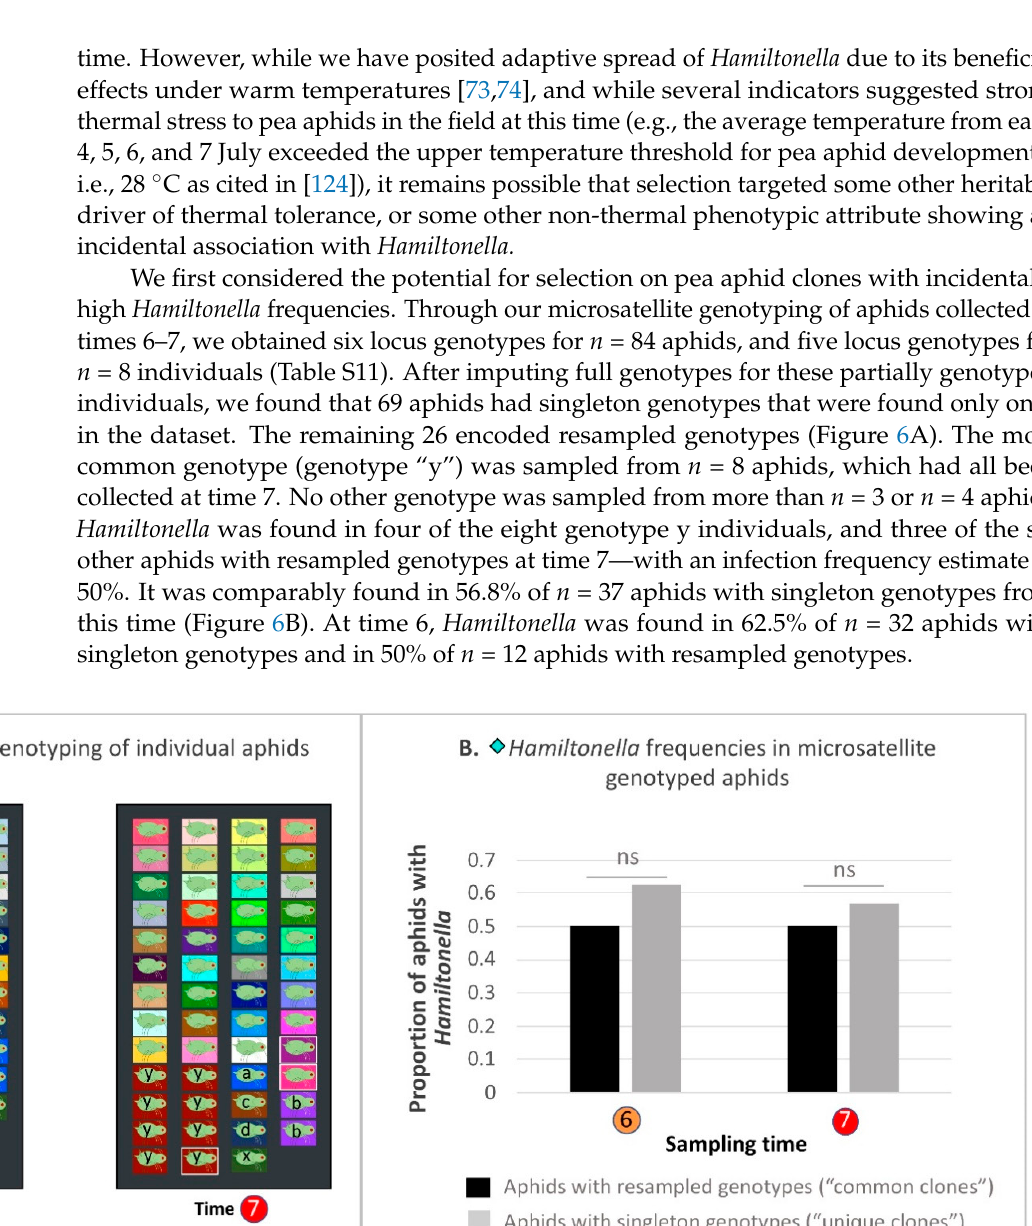
26 of 38 Figure 5. Direct selection vs. hitchhiking effects for facultative symbionts of pea aphids across overwintering periods. As shown in Smith et al. 2021, Hamiltonella frequencies declined across two overwintering periods. Illustrated here, in addi- tion to Hamiltonella , are dynamics for the other six symbionts. Unlike Hamiltonella , none showed consistent effects across the 2012–2013 and 2013–2014 overwintering periods, although the frequency of co-infections between Serratia and Rick- ettsiella seemed to rise across both (panels D , H ; see also Figure S3). ( A ) Sampling scheme across overwintering periods, in addition to a description of the pea aphid lifecycle, across these spans, for cyclically parthenogenetic aphids. Colored arrows indicate sampling times (in October and May) and correspond to the colored circles/ovals used in B-H (in which